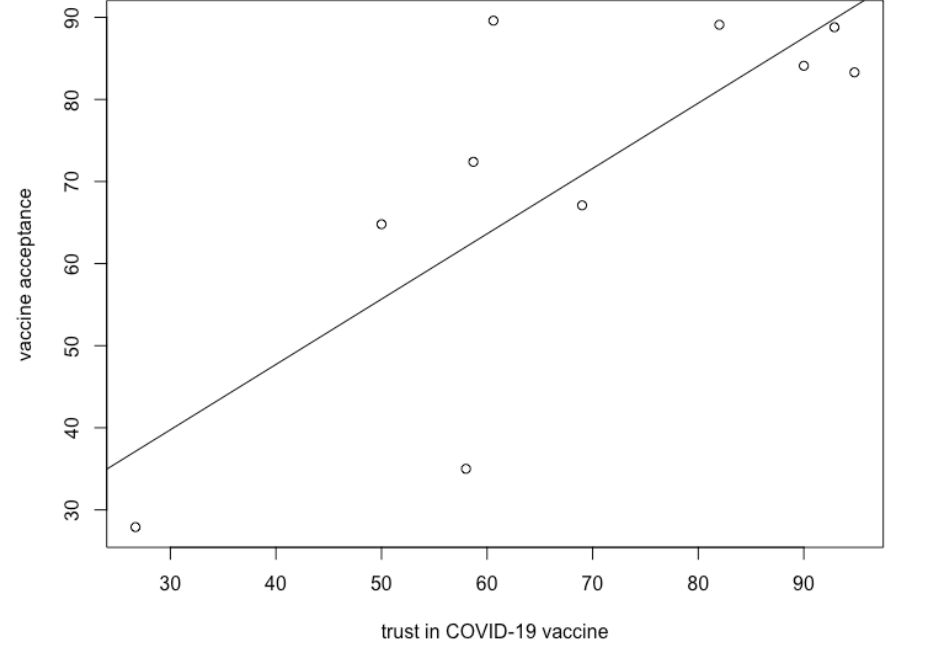
Figure 2. Regression chart on the relationship between trust in the COVID-19 vaccine and vaccine